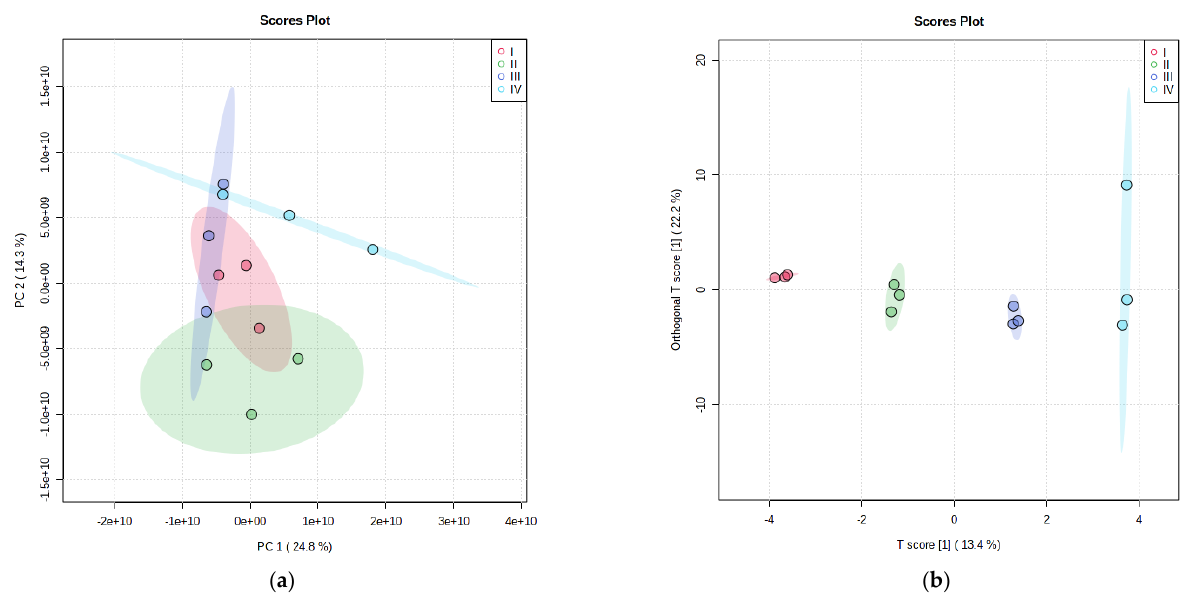
Figure 10. PCA ( a ) and OPLSDA ( b ) analysis of metabolite network of biolayers from museum necropolises.